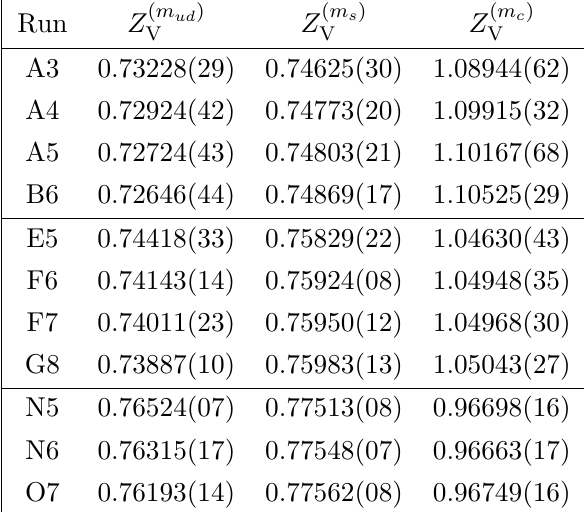
Table 8 . Results for the mass-dependent renormalization factor Z ( m f ) puted for degenerate active and spectator quarks, f = f 0 = ud; s; c . Numbers in parentheses denote statistical